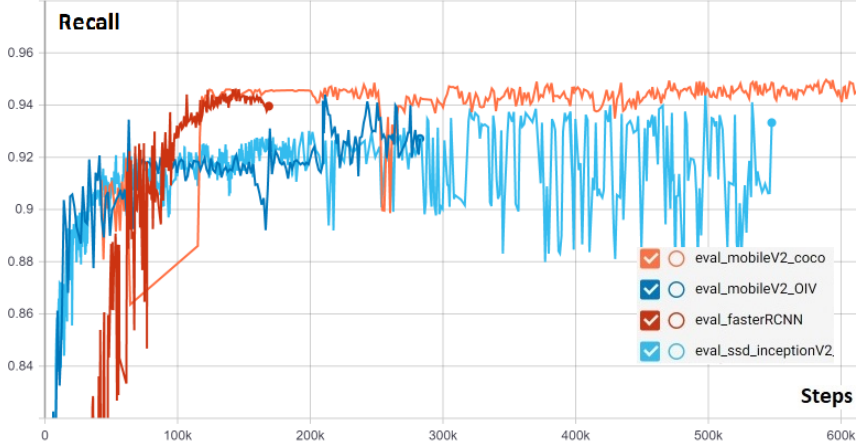
Figure 3. Recall of the trained models using Pascal VOC metrics.